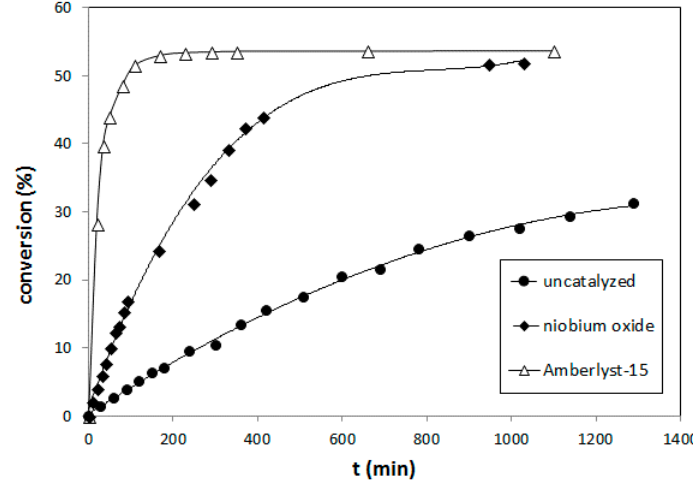
Figure 8. Conversion profiles versus time for the esterification of lauric acid with methanol at 110 °C and 1:1 acid:alcohol molar ratio—comparison of the uncatalyzed reaction with the niobium-oxide- and Amberlyst-15-catalyzed systems.